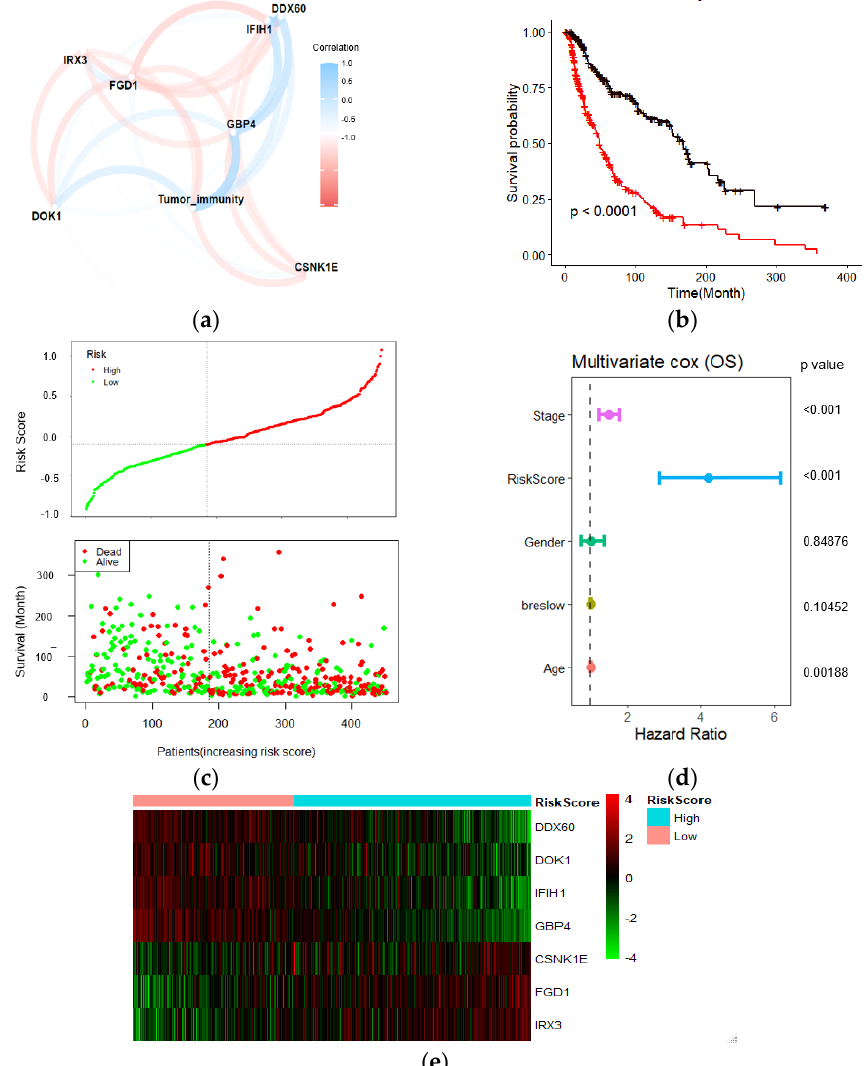
Figure 4. Prognostic analyses of 7 gene signatures in TCGA dataset. ( a ) Pearson correlations of the seven gene signatures with the tumor immune score. Four genes showed a positive correlation with tumor immune score, and three negatively correlated. The line thickness represents the correlation value; ( b ) Kaplan–Meier analysis showed higher risk scores correlated with worse OS; ( c ) Risk score distribution in TCGA dataset; ( d ) Multivariate Cox regression analysis revealed that risk score was an independent risk factor for OS; ( e ) Heatmap of the candidate genes in the prognostic